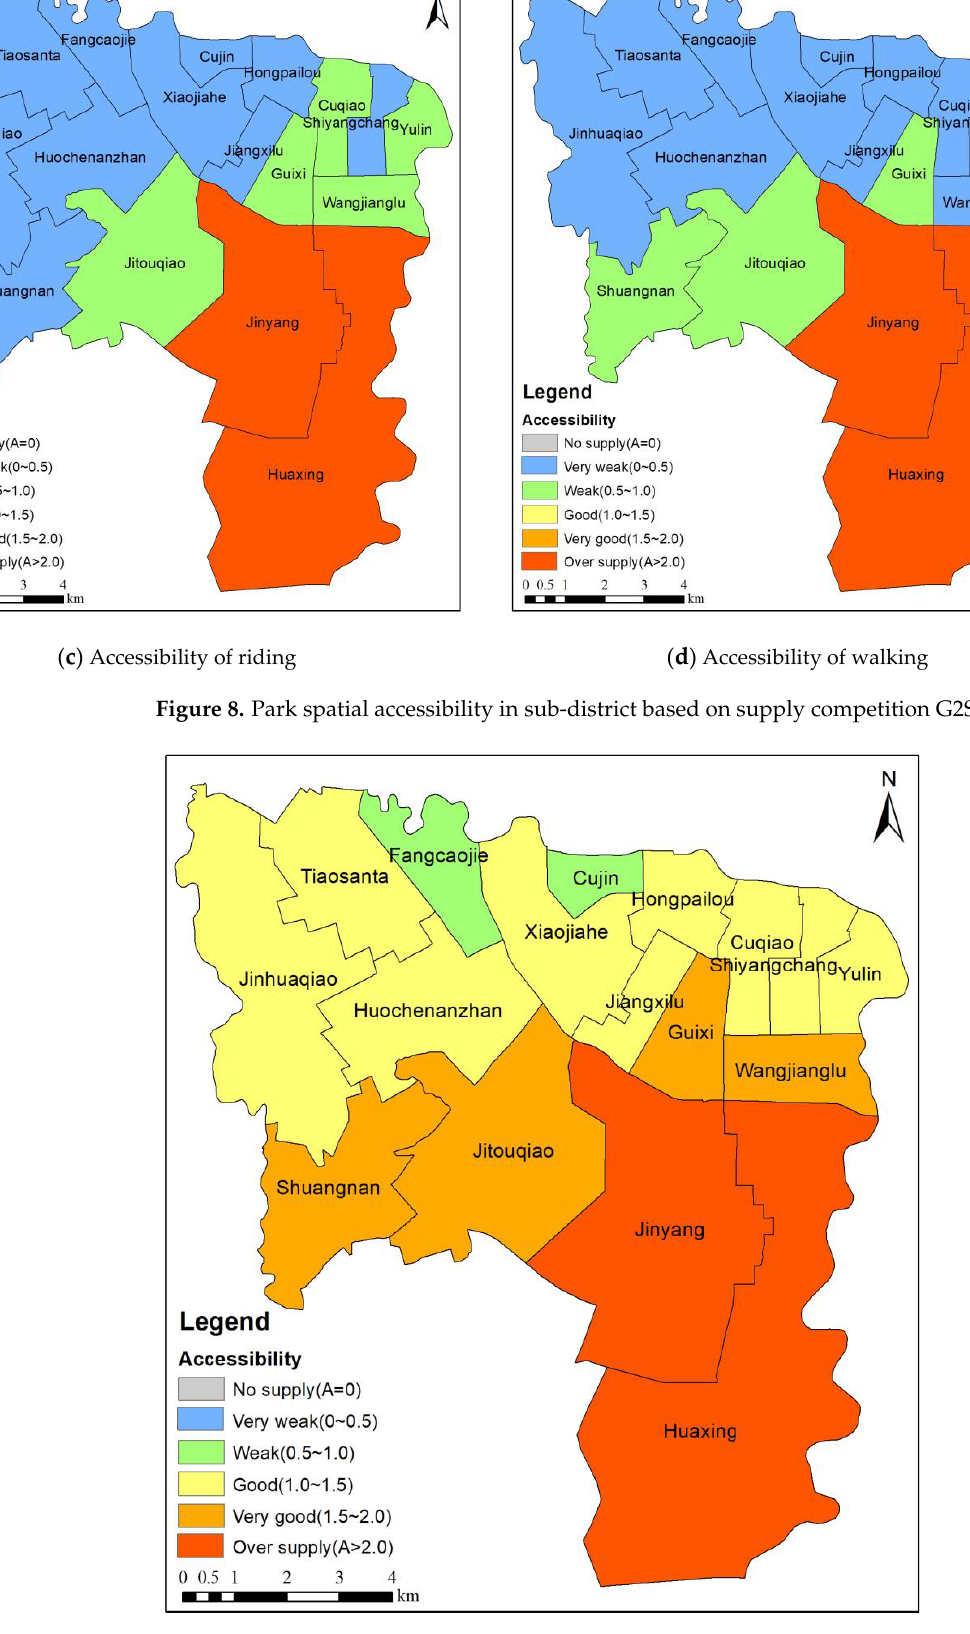
10). The red area is the HH cluster type, which indicates the residential areas with high accessibility in this area. The blue area is the LL cluster type, which indicates that the area is clustered with residential areas with low accessibility. The grey area is the not signifi- cant type, indicating that there are no residential areas with significant high accessibility or with low accessibility. It can be seen from the cluster type in Figure 10 that there are obvious spatial differences in park accessibility. The Shiyangchang and Guixi sub-districts in the south cluster high accessibility residential areas, which can obtain sufficient park services and are the most ideal residential areas. The five sub-districts in the north, Jinyang, Shuangnan, Hongpailou, Jitouqiao and Jiangxilu, lack parks with large area and high service quality, clustering a large number of low-accessibility residential areas, and the park services are scarce. Therefore, relevant departments should plan new parks with high service quality in the Hongpailou sub-district in the north, Cuqiao sub-district in the southwest and Wangjianglu sub-district in the northeast. The number of parks should be increased to meet the park service needs of low accessibility residential areas and better allocate urban park resources.